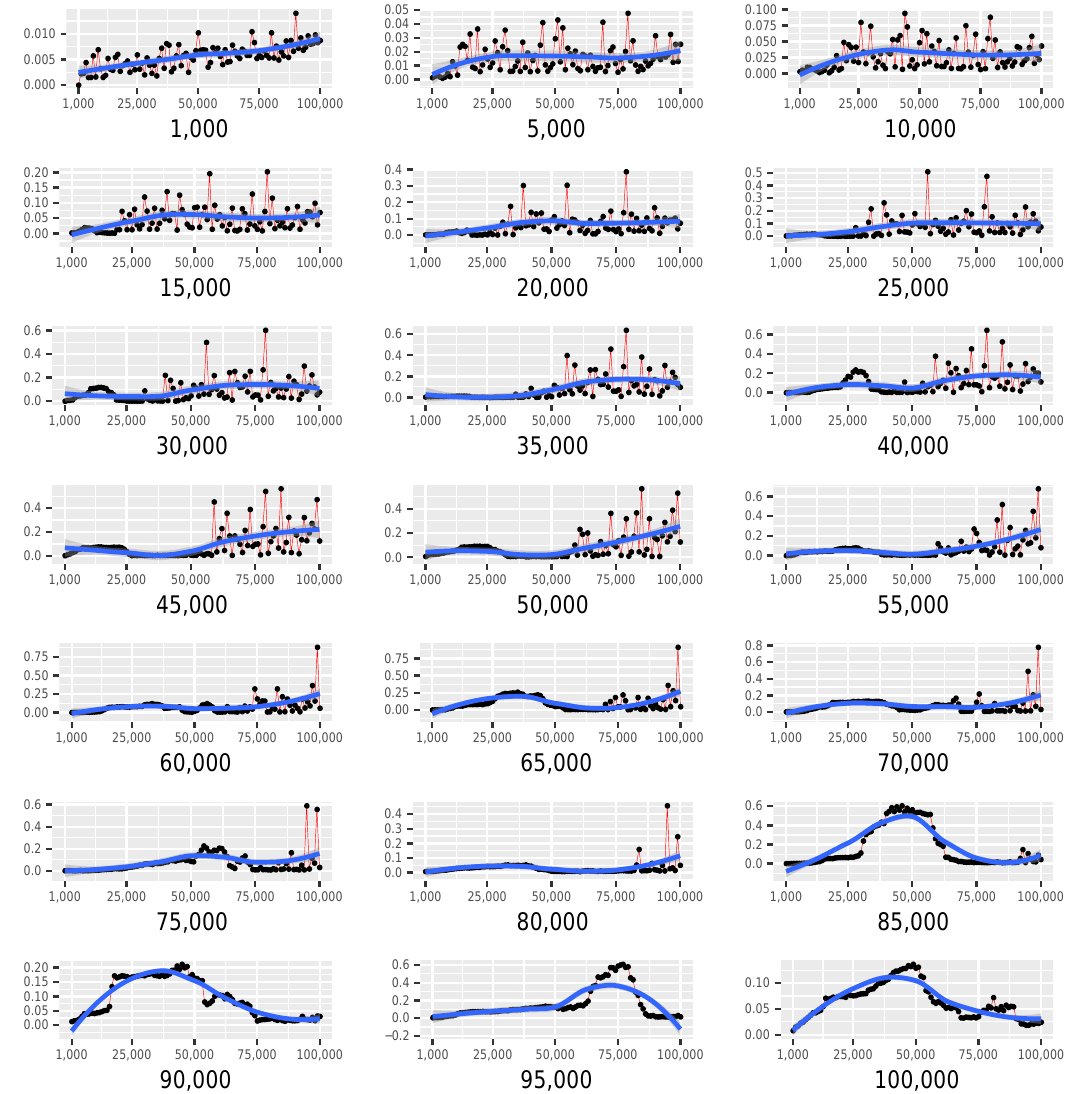
Figure 7. Scatter plots with fitted curves of the median running times (in seconds) of L UMÁWIG R over 100 computations of dimension zero bottleneck distance between a base diagram with the labeled number of points and a diagram with k thousands of points, for k = 1,2, . . .